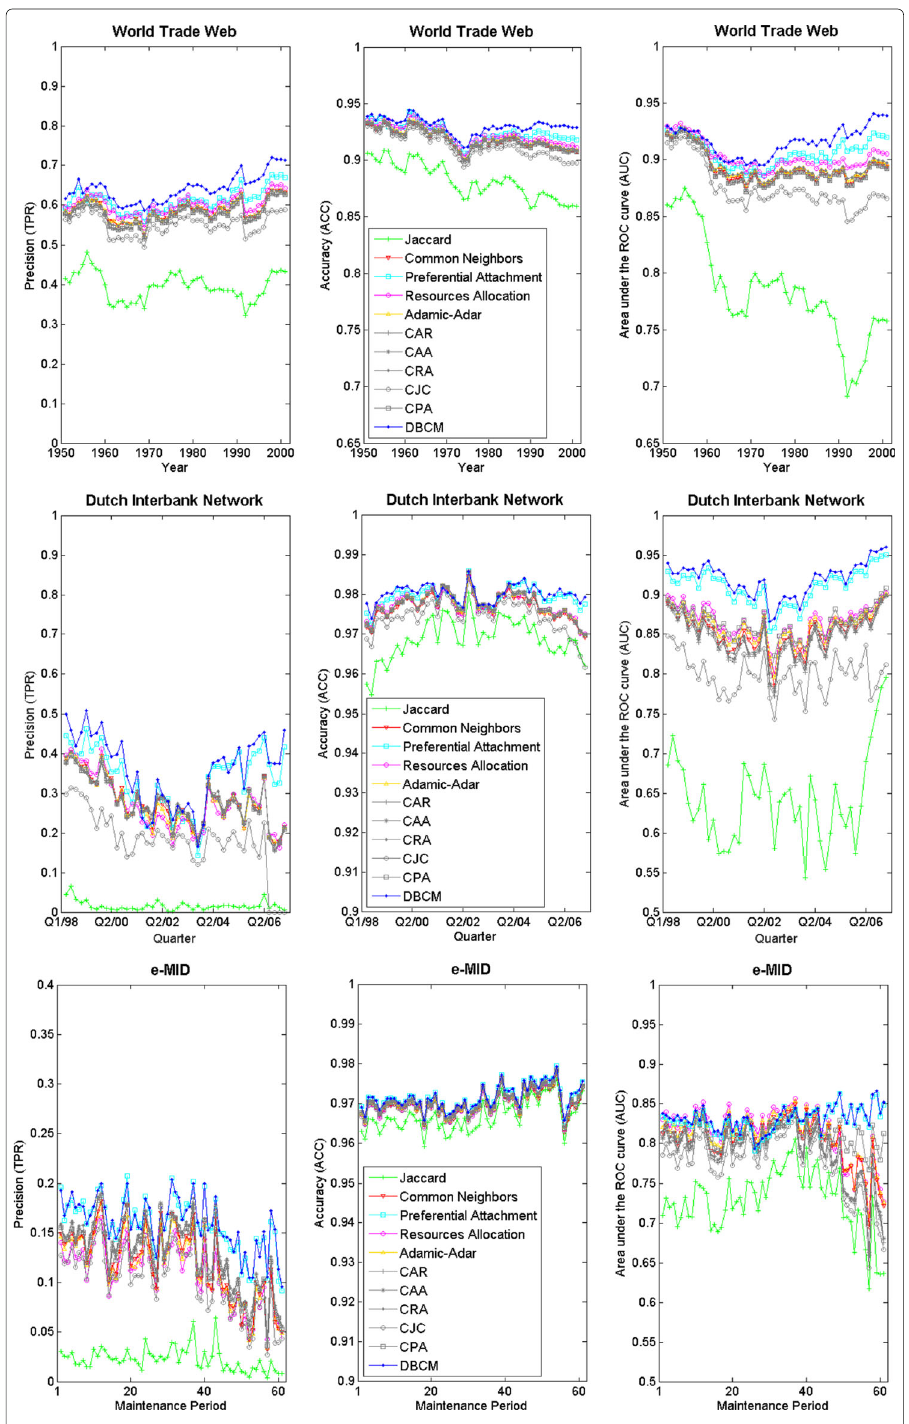
Fig. 1 Comparison of link-prediction algorithms when applied to the undirected version of the WTW (top), the DIN (middle) and e-MID (bottom). Left panel: evolution of precision; middle panel: evolution of accuracy; right panel: evolution of AUC. Our entropy-based approach to link-prediction performs better than other algorithms, across the vast majority of temporal snapshots. Notice that PA implements the recipe s PA ij = k i · k j . See also Fig. 4 for a visual inspection of the errors accompanying the estimations shown